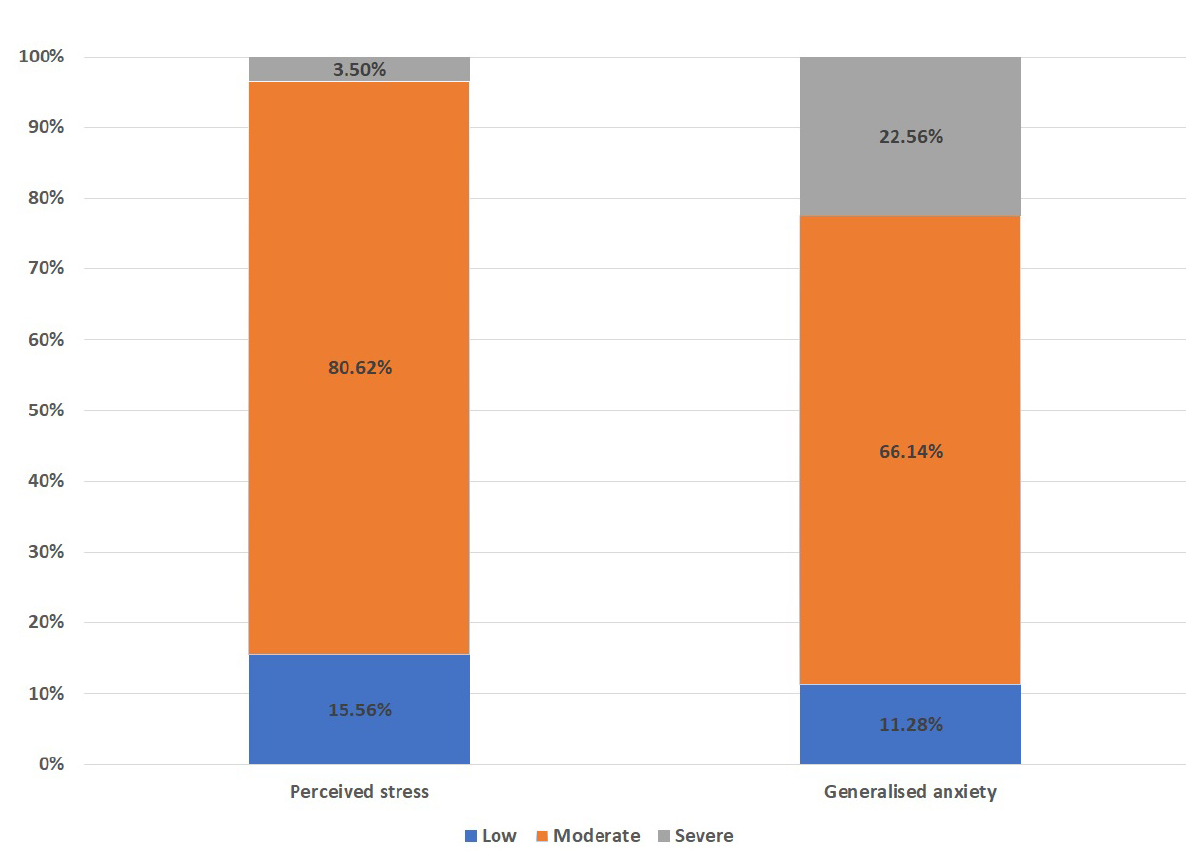
Figure 1. Percentage of perceived stress & generalized anxiety stress in Indian